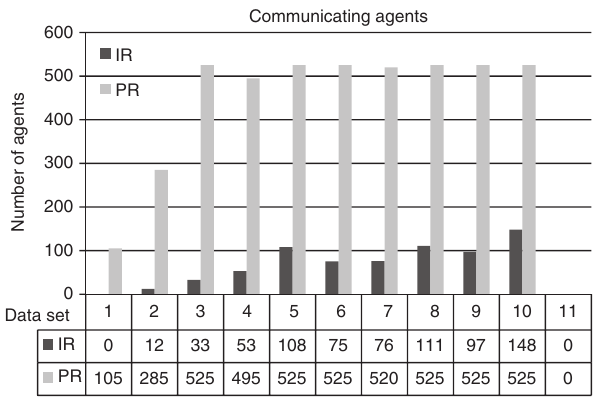
Figure 5. Communicating Agents: Number of Intent-Recognition (IR) Agents and the Number of Plan-Recognition (PR) Agents that Communicated for Each Data